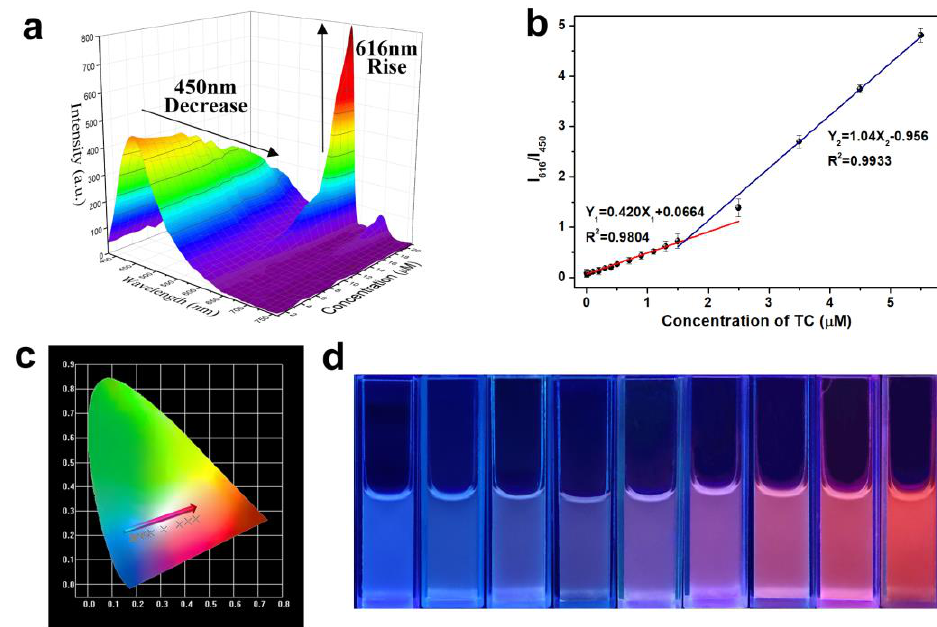
Figure 5. ( a ) The emission spectra of SiCDs@mMIP-cit-Eu in the presence of different TC concentra- tions. ( b ) The fitting curve of SiCDs@mMIP-cit-Eu between the relative ratios of (I 616 /I 450 ) and TC concentrations ranging from 0 to 5.5 μM, and the error bars represent the standard deviation from three parallel tests. ( c ) CIE chromaticity diagram showing the (x,y) fluorescent color coordinates of SiCDs@mMIP-cit-Eu with the TC concentrations ranging from 0 to 5.5 μM. ( d ) The fluorescence images of SiCDs@mMIP-cit-Eu probe in the presence of 0, 0.1, 0.5, 1, 2, 2.5, 5, 10, and 20 μM TC under a UV lamp at 365 nm.